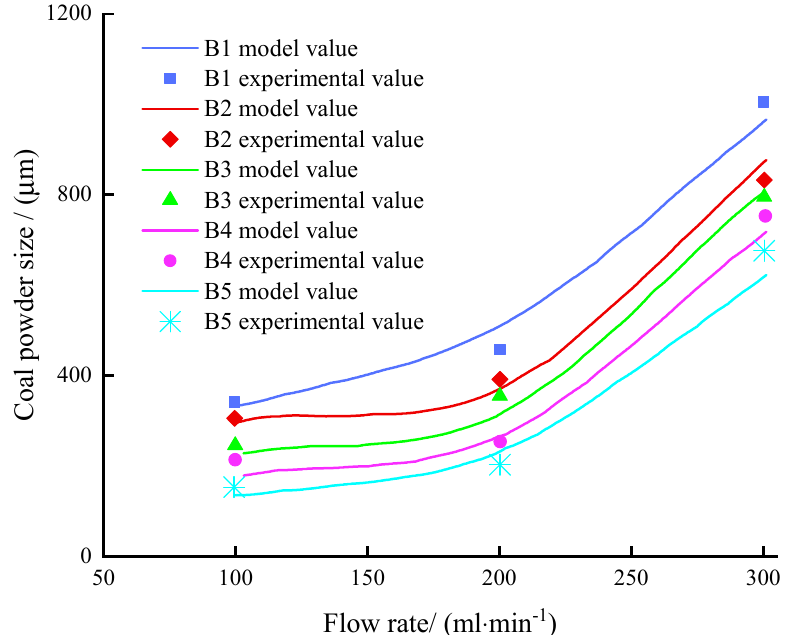
Figure 14. The relationship of coal powder particle size and flow rate.